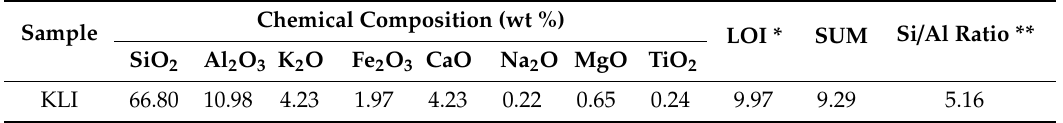
Table 1. Chemical composition of natural zeolite Klinofeed ® .